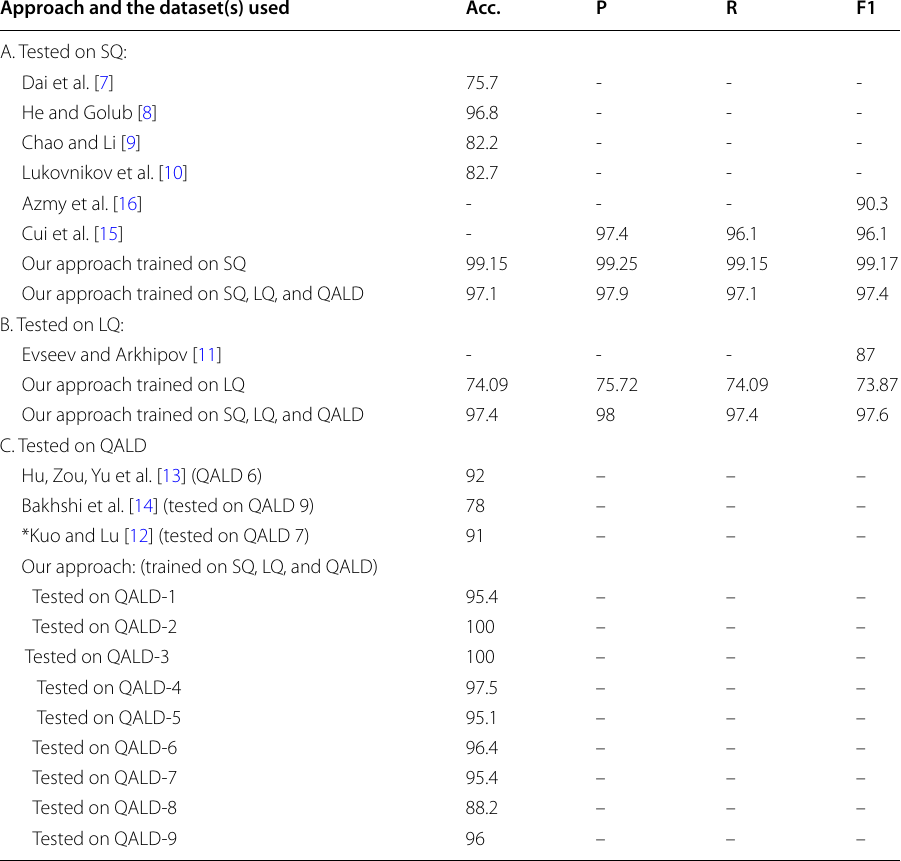
Table 7 Comparison of entity detection performance on testing dataset (in percent). SQ and LQ refer to SimpleQuestions and LC-QuAD 2.0 dataset, respectively Approach and the dataset(s) used